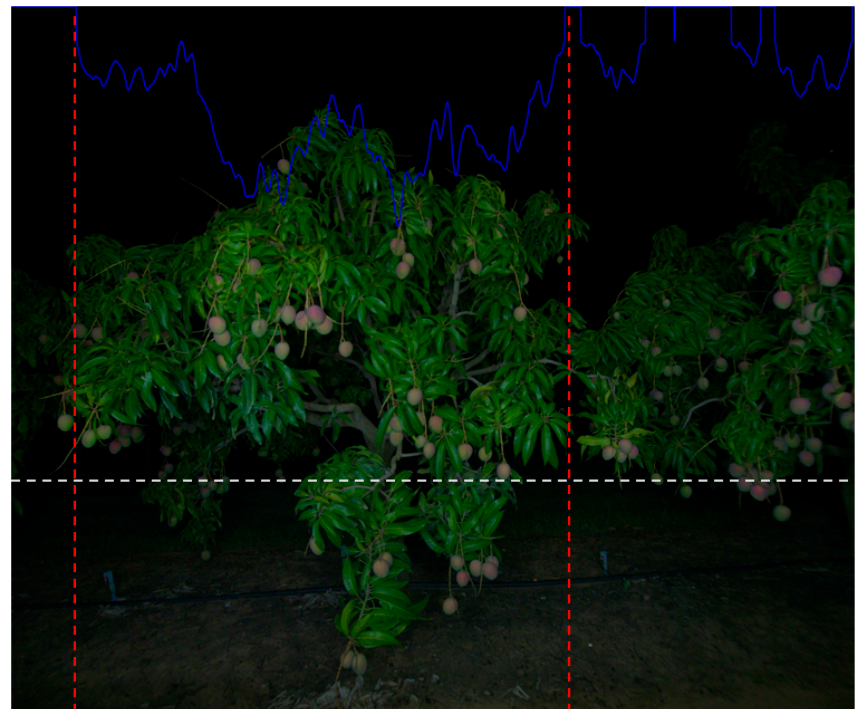
Figure 2. Auto tree segmentation. The Otsu’s method was applied to the image above the white line. The sum of intensity of each pixel column x -1 is illustrated as the blue line (zero at image top). Moving away from the image center in each direction, two near zero minima were identified (illustrated with red lines) and used to segment each tree. Canopy segmentation was based on the top two thirds of the image (as denoted by the white horizontal dash line, approximately 1.5 m above ground), as this part of the image carried the sky silhouette of the canopy and the max width of the canopy.